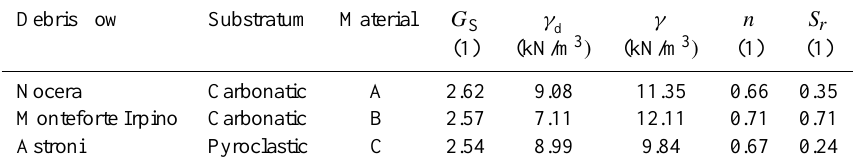
Table 1. Main physical properties of the tested debris flow materials.